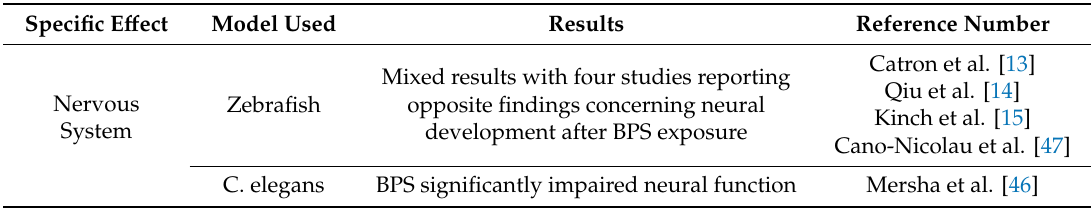
Table 4. Summary of dietary BPS exposure and the nervous system.